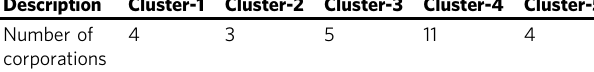
Table 3 Peer clusterisation cement corporations in Indonesia.